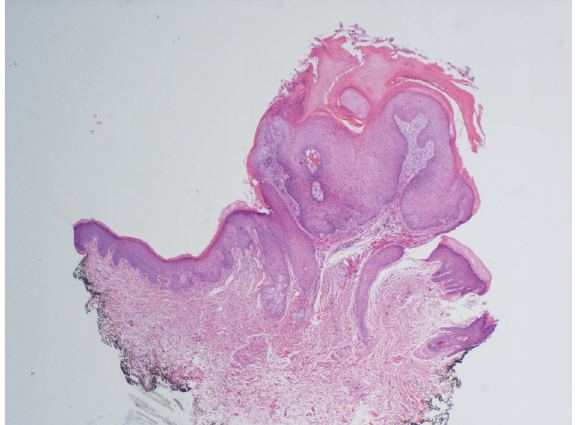
Figure 1: A well-circumscribed, dome, or cup-shaped central crater filled with keratin.